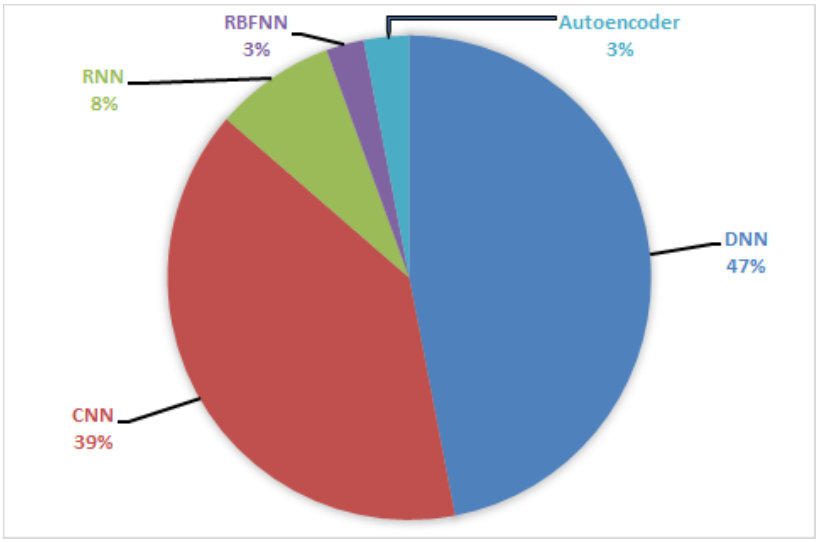
Figure 6. Percentage of papers surveyed by DL